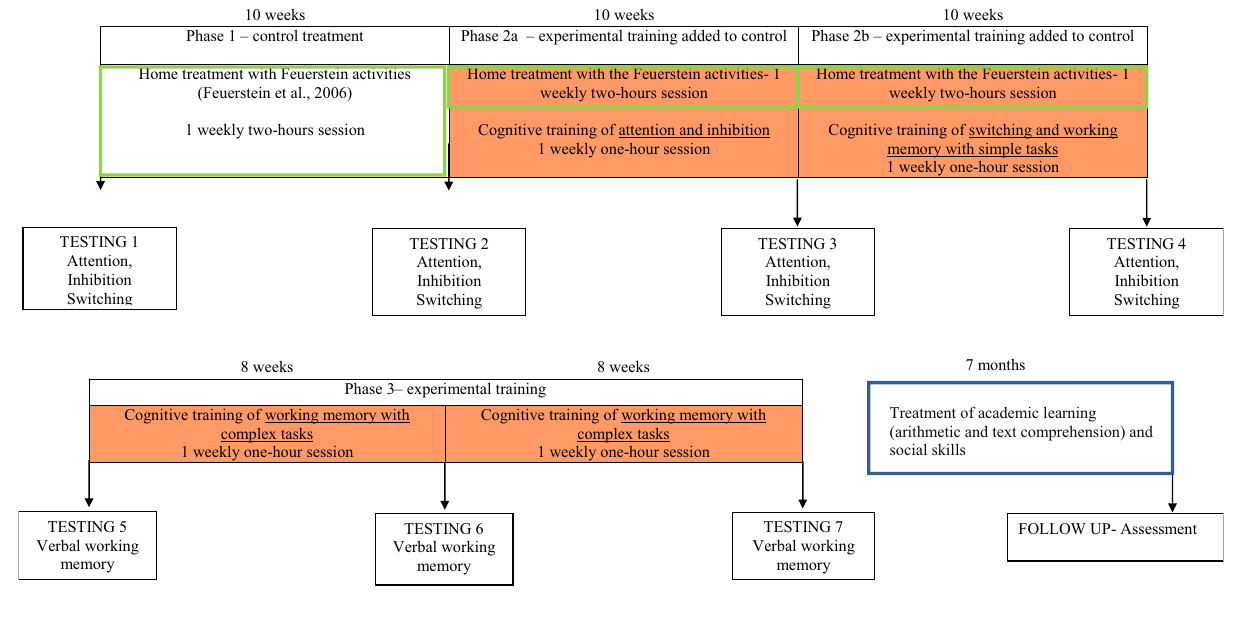
FIGURE 1 | The research